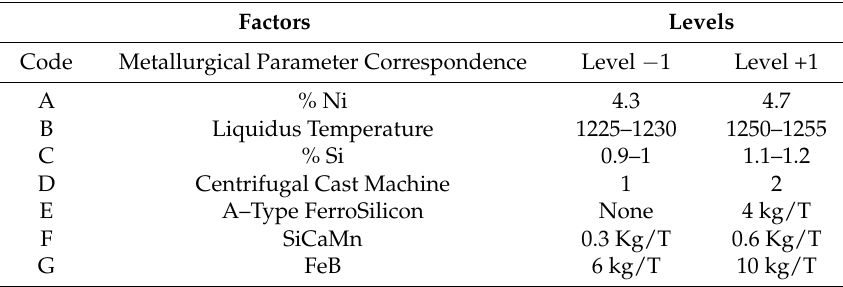
Table 3. Factors and Level Description for DOE.